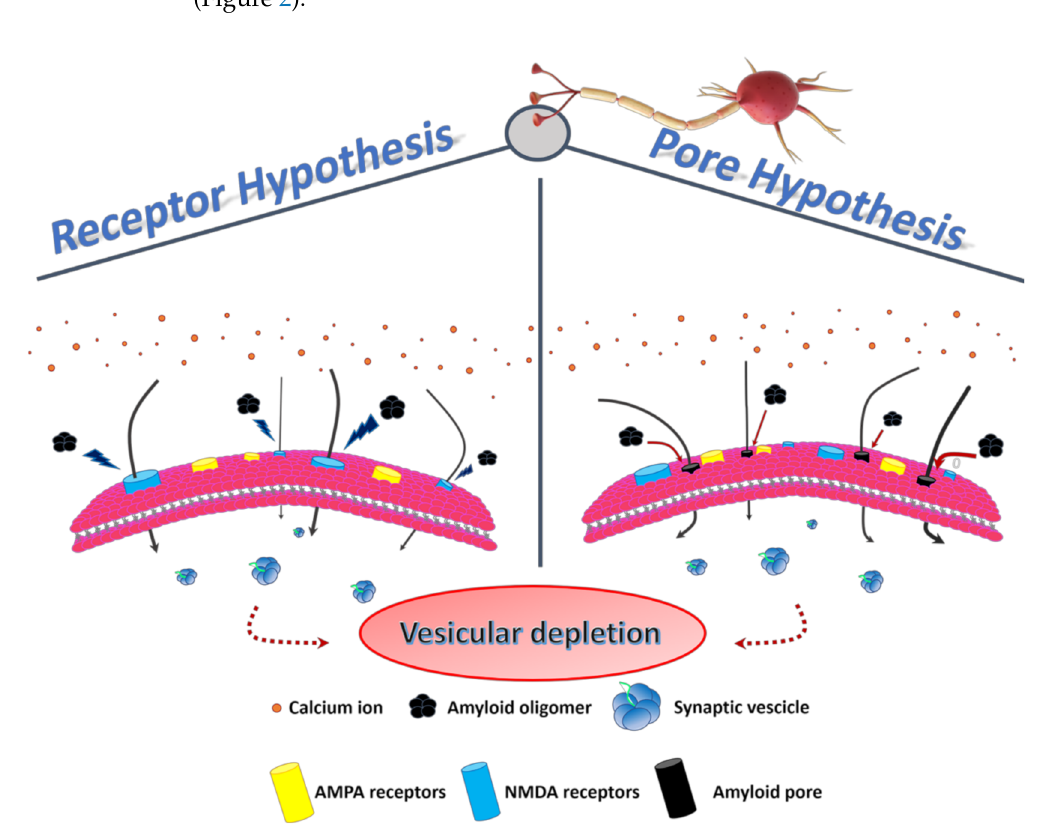
Figure 2. Membrane permeability and vesicular depletion. In the physiological condition, membrane receptors regulate the entry of Ca 2+ into the cell, ensuring the preservation of the pool of vesicles containing the neurotransmitter. In the pathological condition, characterized by the unbalance of the Ca 2+ influx, two hypotheses have been formulated to explain the altered membrane permeability: in the first, PFOs directly activate NMDA receptors (receptor hypothesis), while in the second, PFOs form pores (continuous red arrows) in the membrane (pore hypothesis). Increased Ca 2+ influx (black arrows) results in vesicular depletion (dashed red arrows) and consequent cell